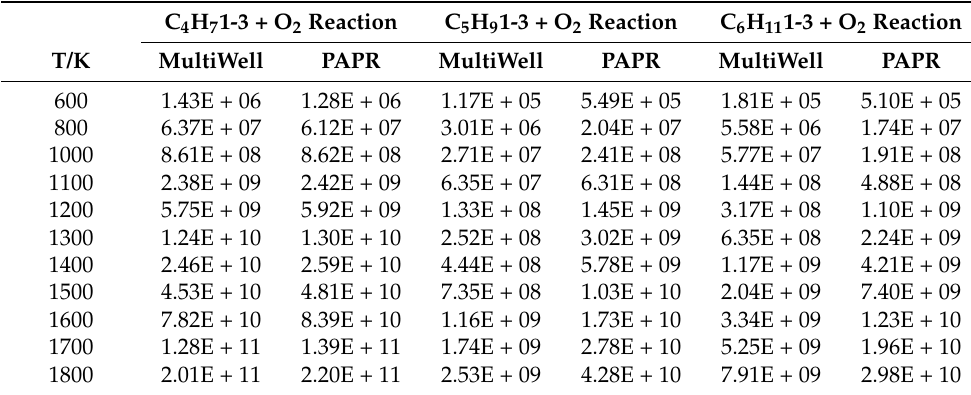
Table 4. Rate constant comparison for two kinetic solvers: MultiWell and PAPR.